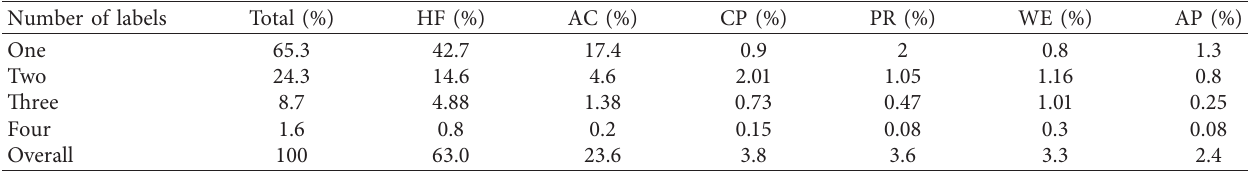
Table 5: The distribution of the number of labels along with distribution of labels within each number.